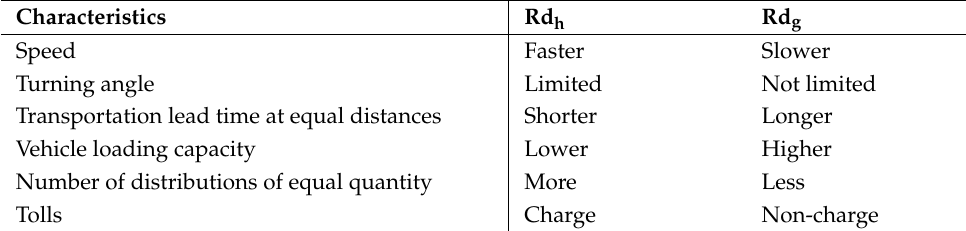
Table 1. Transportation characteristics of two different road